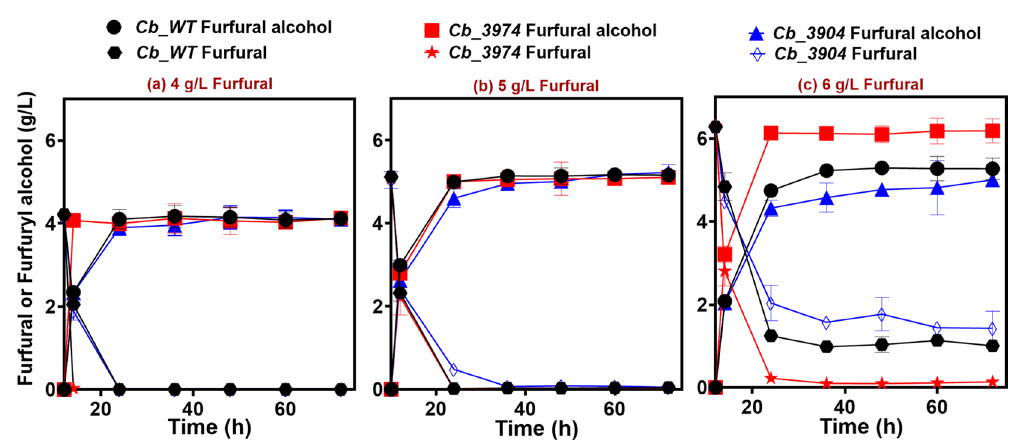
Figure 4. Furfural detoxification profiles of Cb _3974, _3904, and _wild type in furfural (0–6 g/L)-challenged